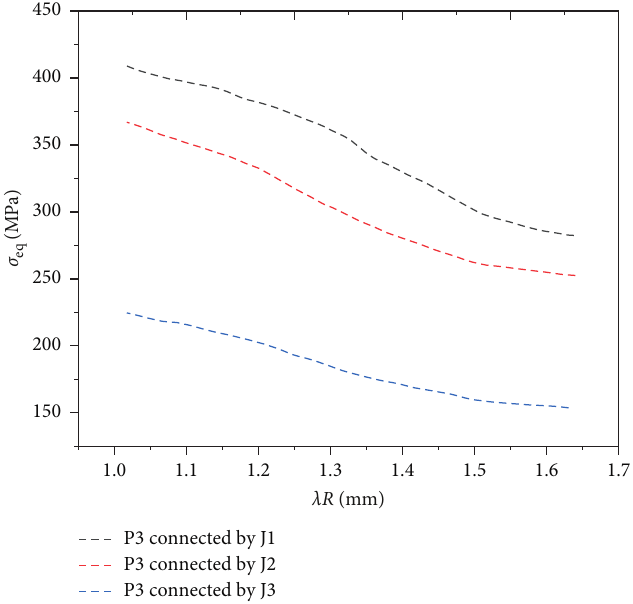
Figure 10: Distribution of σ eq along the radial direction in the steel pipe at room temperature.